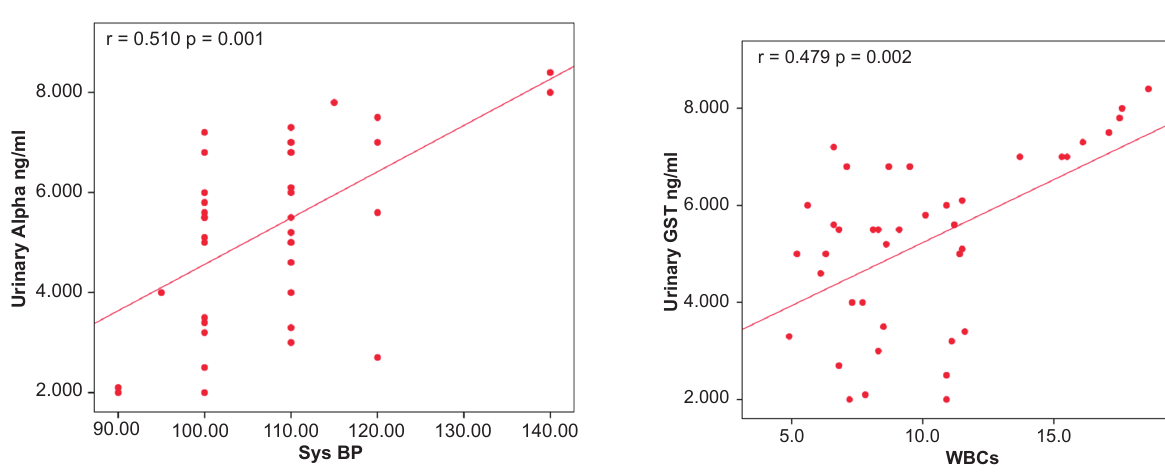
Figure 1: Correlation between urinary alpha glutathione S-transferase and systolic blood pressure.